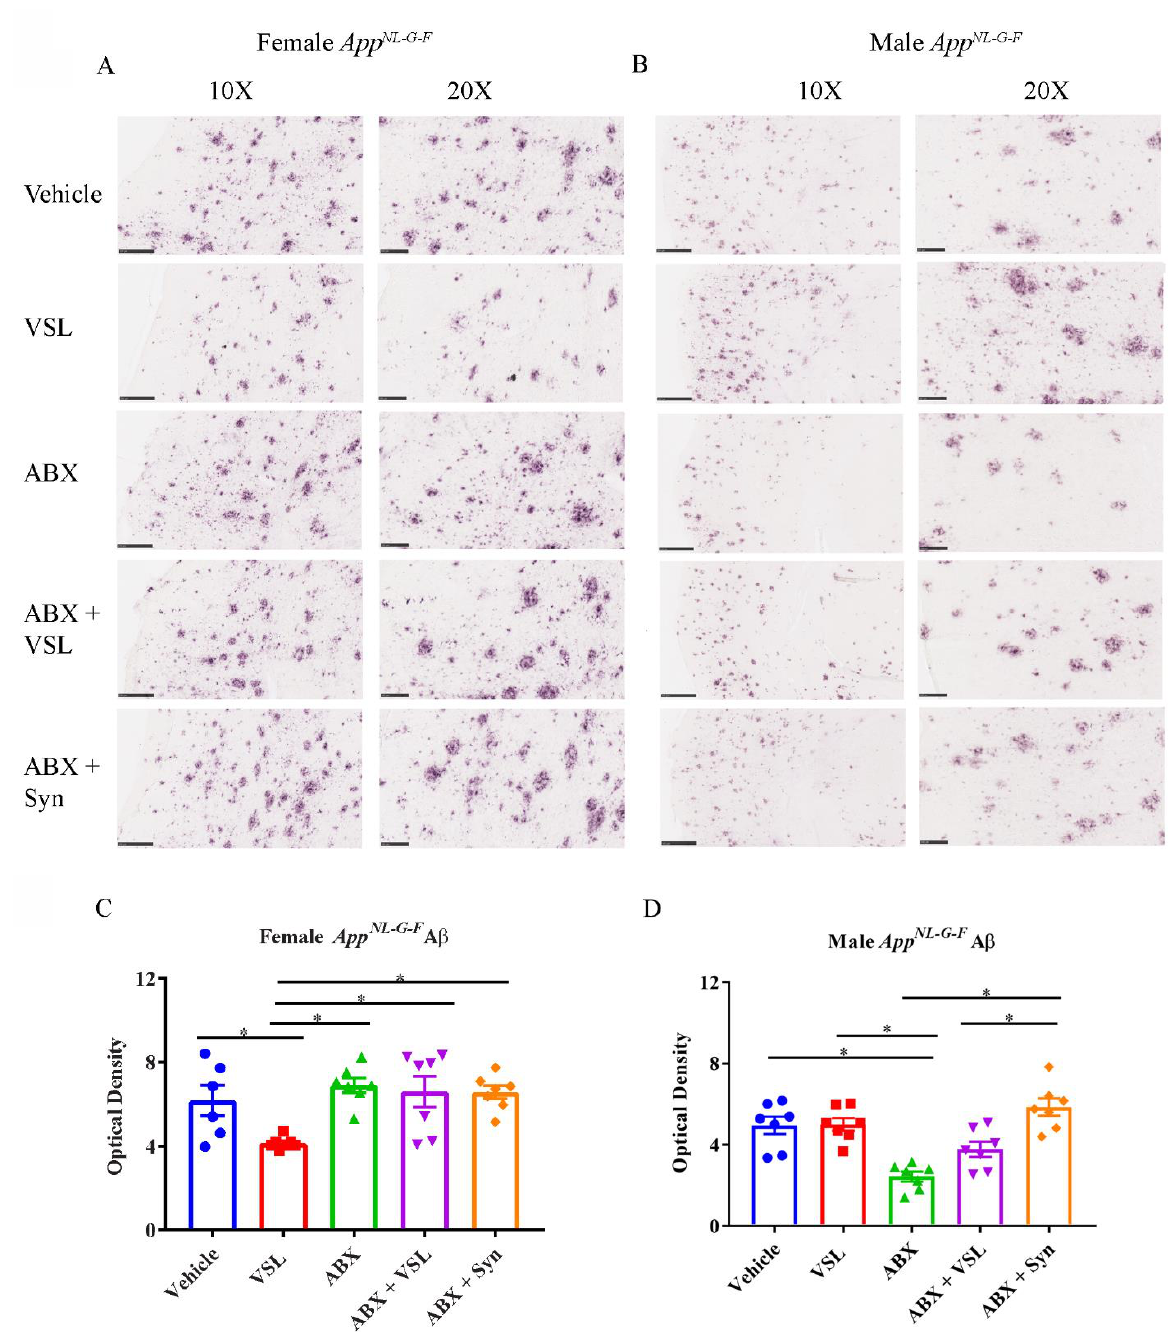
Figure 2. Effect of probiotic and antibiotics treatments on Aβ accumulation in App NL-G-F brains. Representative immunohistochemical staining images for Aβ from temporal cortices of mice treated with vehicle, VSL#3, antibiotics (ABX), antibiotics+VSL#3 (ABX + VSL), and antibiotics+VSL#3+prebiotic (ABX + Syn) are shown for ( A ) female and ( B ) male App NL-G-F mice. ( C , D ) Quantitation of immunostaining was performed from two sections from each animal, and optical density values were averaged and presented as mean ± SEM. Significant differences were determined by a one-way analysis of variance, * p < 0.05 ( n = 7). Scale bars are 100 µm (10×) and 50 µm (20×).